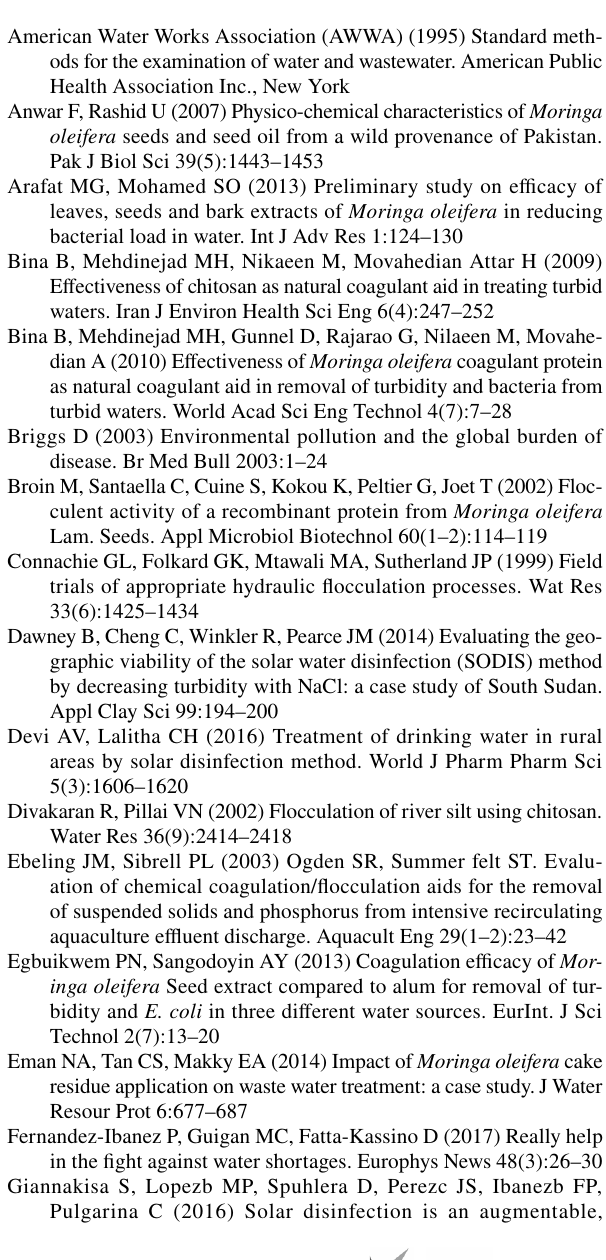
Fig. 6 Combined turbid water treatment